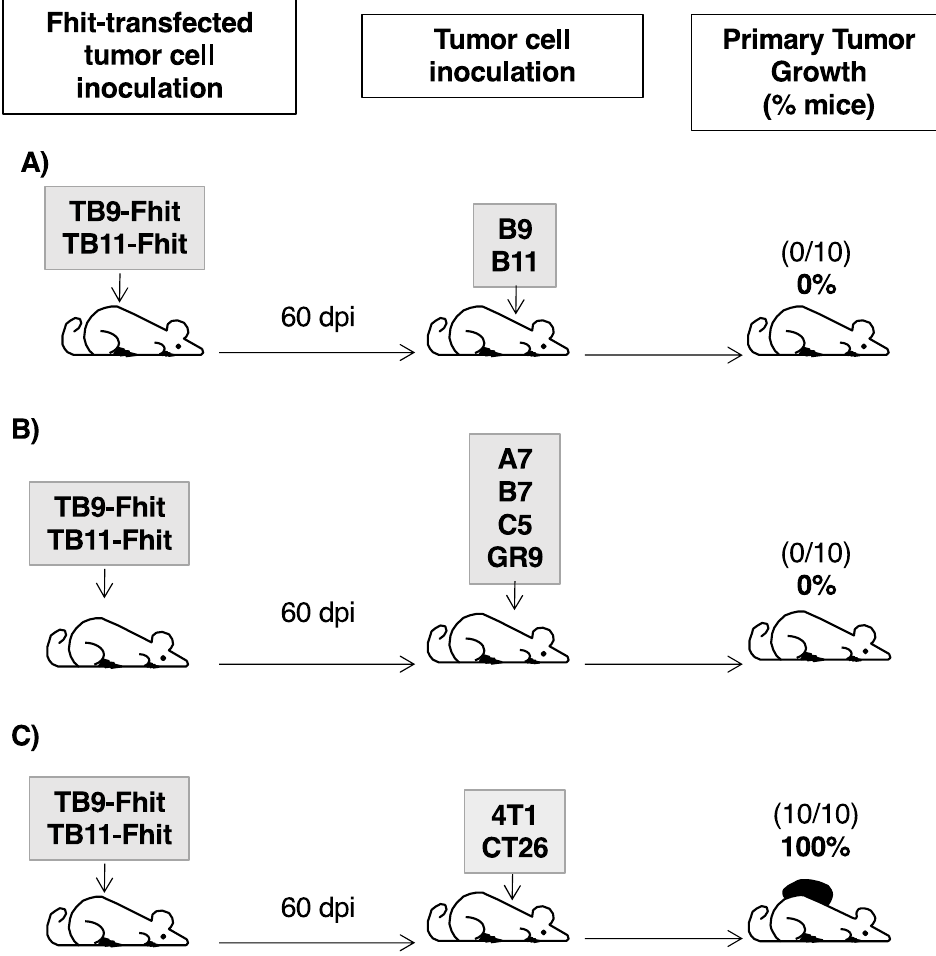
Figure 5. Immunogenicity and immunoprotection of female mice inoculated with Fhit-transfected B9 / B11 tumor cells. ( A ) TB9- and TB11-Fhit immunoprotected the hosts against B9 and B11 tumor cells. The animals ( n = 10 mice per group) were previously inoculated with Fhit-transfected tumor cells and then, 60 days later, inoculated with non-transfected tumor cells; B9 and B11 tumor cells were immune rejected in all mice; ( B ) TB9- and TB11-Fhit immunoprotected the hosts against other tumor cell clones of the GR9 tumor system and even against GR9 bulk tumor cells; ( C ) TB9- and TB11-Fhit did not immunoprotect the hosts against 4T1 breast carcinoma cells or CT26 colon carcinoma cells. The assays were repeated twice.